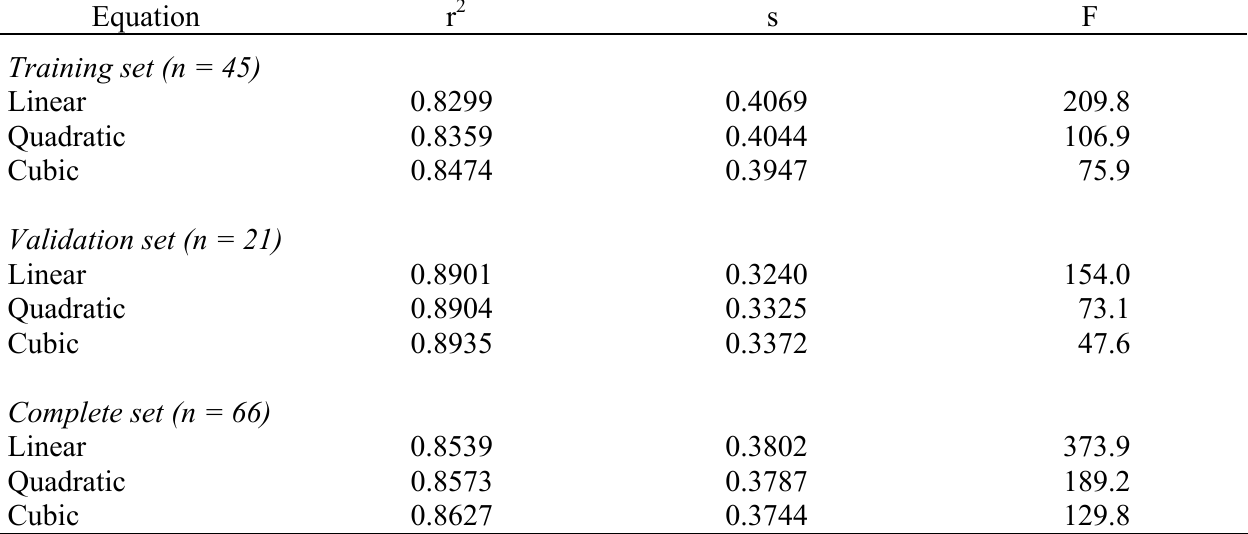
Table 4 . Statistical results corresponding to linear, quadratic, and cubic regression equations for training and test sets,